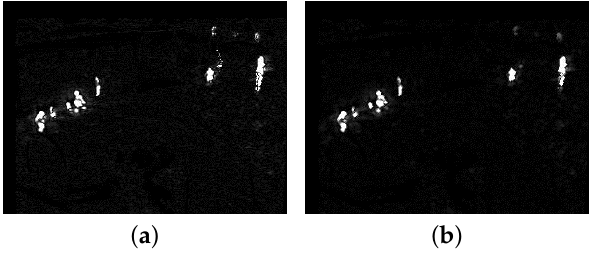
Figure 3. The two foreground probability maps of Figure 2a. ( a ) The original foreground probability map; ( b ) the foreground probability map with dilation following erosion.